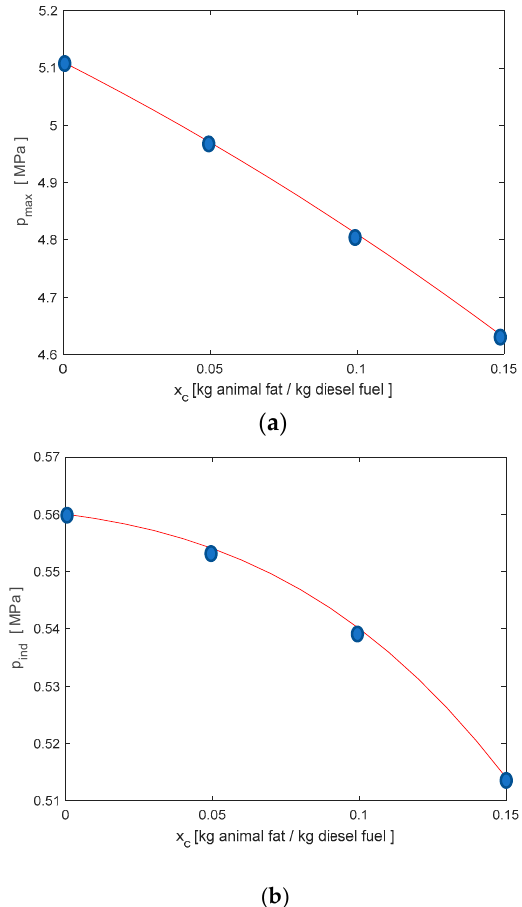
Figure 11. Maximum pressure ( a ) and indicated mean pressure ( b ) variation for different x c , at constant engine setup parameters.